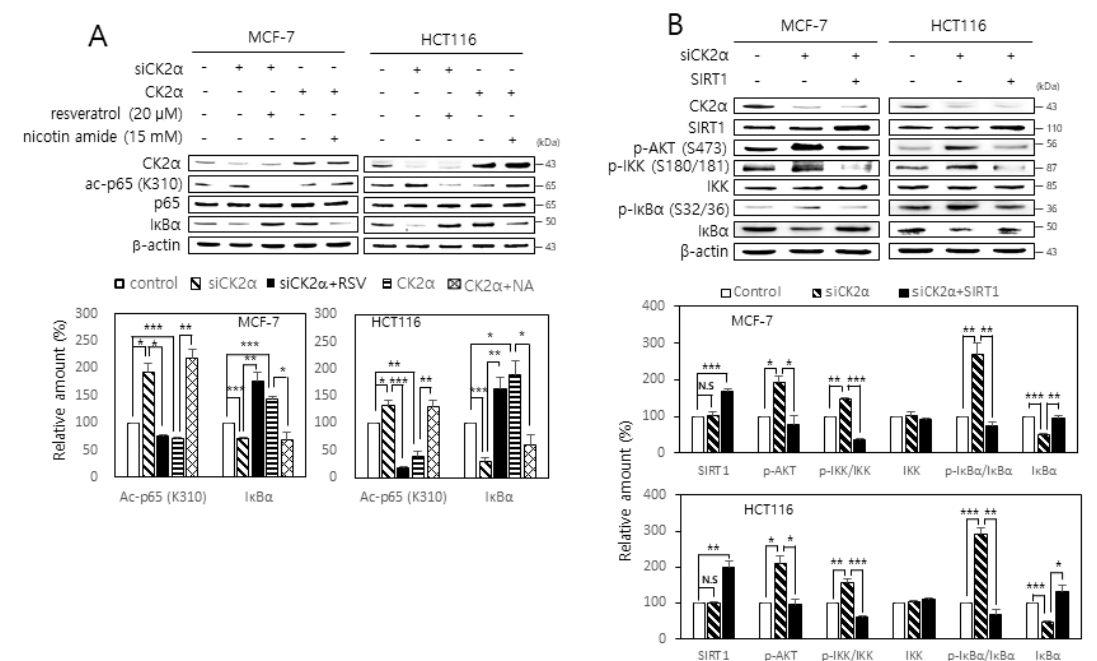
Figure 3. SIRT1 attenuates both RelA/p65 acetylation and activation of the AKT-IKK-I κ B axis mediated by CK2 down- regulation. ( A ) MCF-7 and HCT116 cells were transfected with CK2 α siRNA or pcDNA3.1-HA-CK2 α for two days in the absence or presence of 20 µ M resveratrol or 15 mM nicotine amide. The level of each protein was determined by immunoblot analysis using specific antibodies ( top ). Representative data from three independent experiments are shown. β -Actin was used as a control. Graphs represent the quantitation of acetylated p65 (ac-p65) relative to unacetylated p-65 ( bottom ). RSV, resveratrol; NA, nicotine amide. ( B ) Cells were transfected with CK2 α siRNA and/or pECE-Flag-SIRT1 for two days. The level of each protein was determined by immunoblot analysis using specific antibodies ( top ). Representative data from three independent experiments are shown. β -Actin was used as a control. Graphs represent the quantitation of p-AKT, IKK, and I κ B α relative to β -actin and that of p-IKK and p-I κ B α relative to unphosphorylated proteins ( bottom ). Data are mean ± SEM. * p < 0.05; ** p < 0.01; *** p < 0.001.